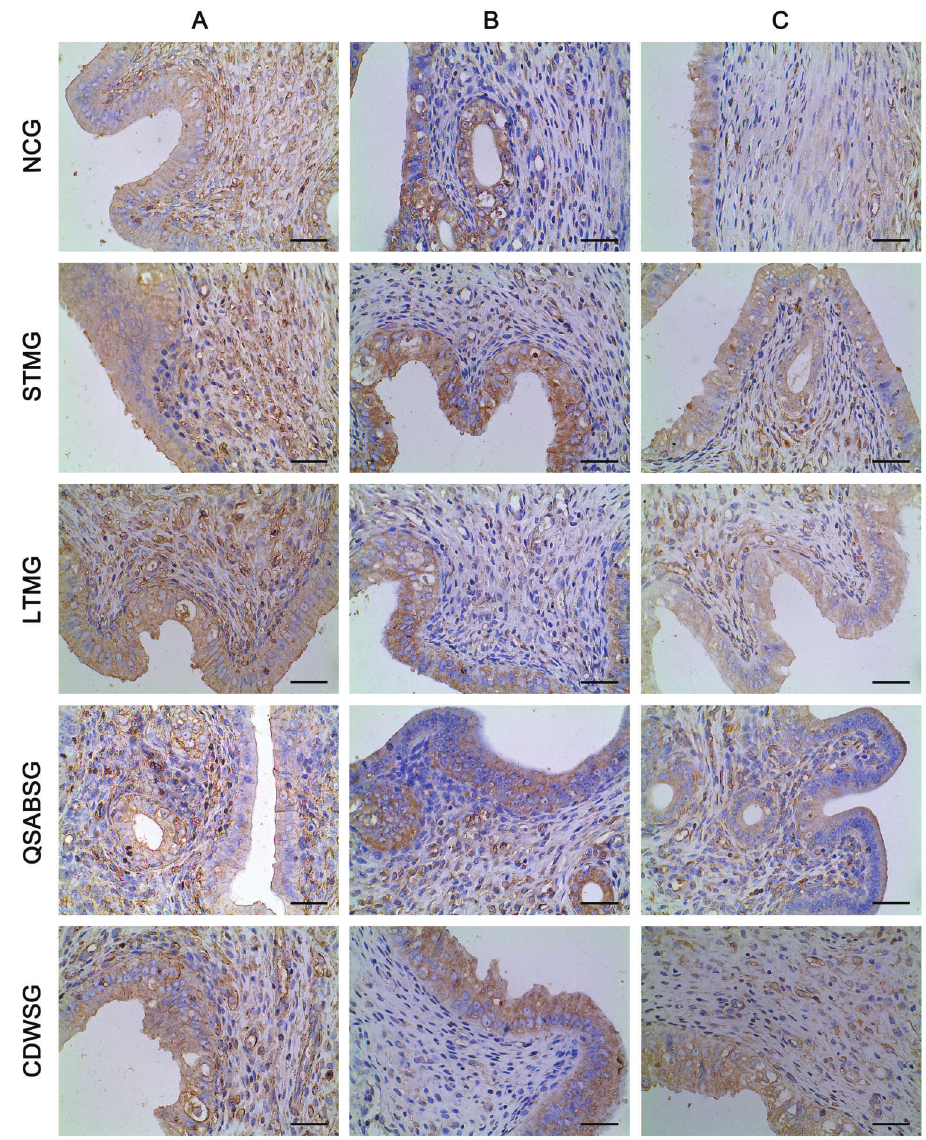
Figure 7. Immunohistochemical characteristics. The tumor cells in STMG, LTMG, and CDWSG were positive for a -SMA ( A ), desmin ( B ), and vimentin ( C ). NCG: normal control group; STMG: short-term model group; LTMG: long-term model group; QSABSG: Qi stagnation and blood stasis group; CDWSG: combining disease with syndrome group. Magni fi cation bars: 40 m